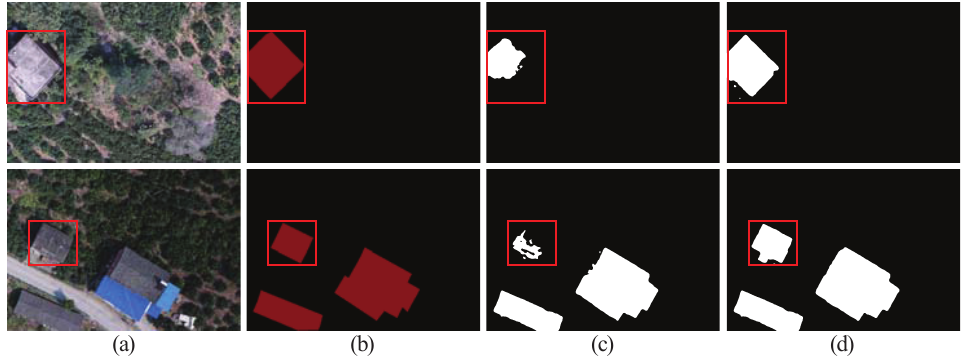
Figure 7. Visualization results of Pixel Attention Module: ( a ) images; ( b ) ground truth; ( c ) pseudo- labels without PAM; and ( d ) pseudo-labels with